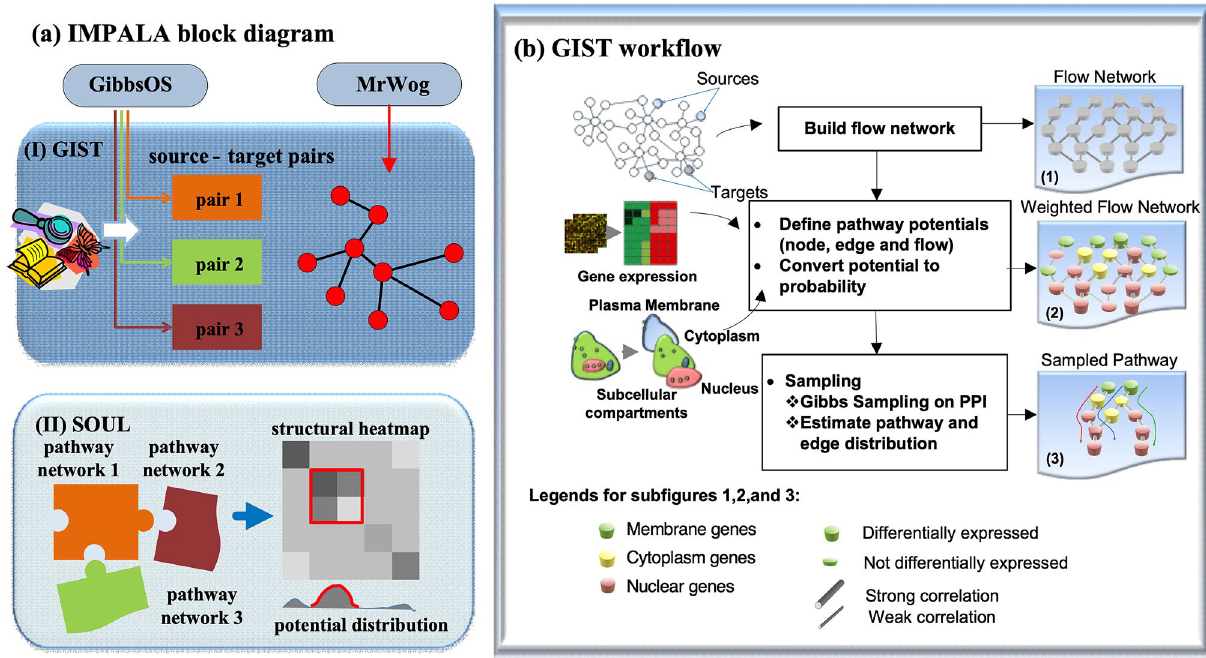
Figure 1. IMPALA block diagram and GIST workflow. ( a ) Key transcription factors and the candidate pathway landscape are identified using GibbsOS and MrWOG to pre-process gene expression and protein–protein interaction data (HPRD database). Then, IMPALA integrates gene expression and candidate pathways to identify aberrant signal pathway transduction using GIST (Gibbs sampler to Infer Signal Transduction) and pathway modules using SOUL (Structural Organization to Uncover pathway Landscape). ( b ) GIST integrates gene (node), gene–gene interaction (edge) and network flow potentials to build a weighted and directed Bayesian network and infers signaling directions between genes using Gibbs